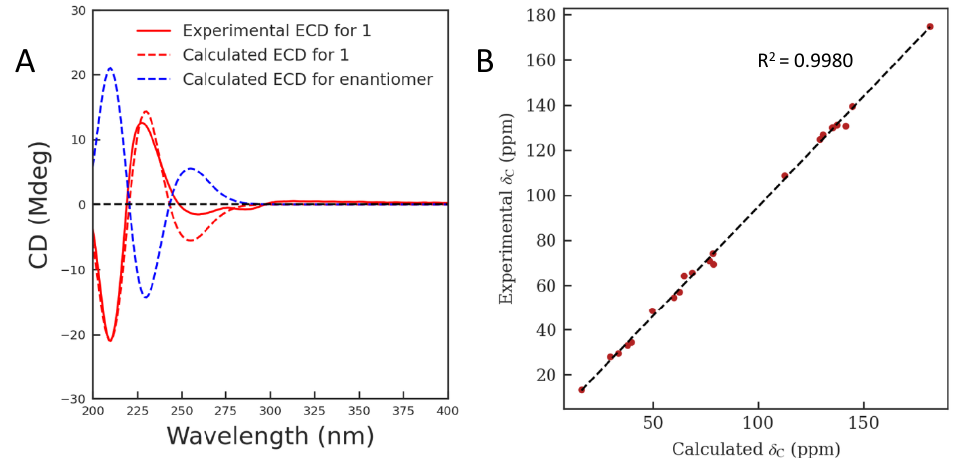
Figure 3. Quantum chemical calculations of compound 1 . ( A ) Calculated and experimental ECD spectra of compound 1 ; ( B ) Regression analysis of experimental versus calculated 13 C NMR chemical shifts of compound 1 .